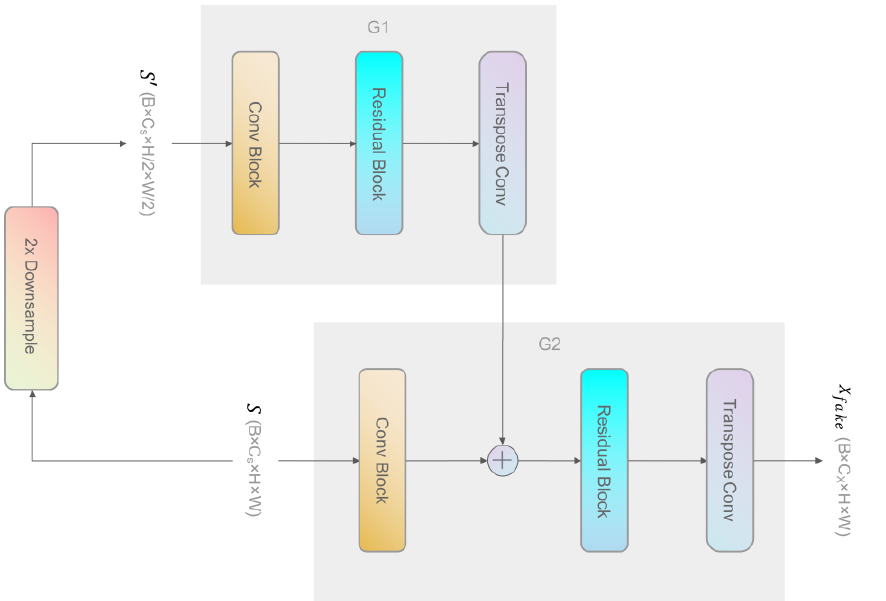
Figure 6. The architecture of the two-scale generation. It is composed of two generators: G 1 and G 2 . G 2 takes the original input S , with the original height (H) and width (W). G 1 takes S (cid:48) as input, which is downsampled from S with a factor of 2 in both the height and width (H/2, W/2).